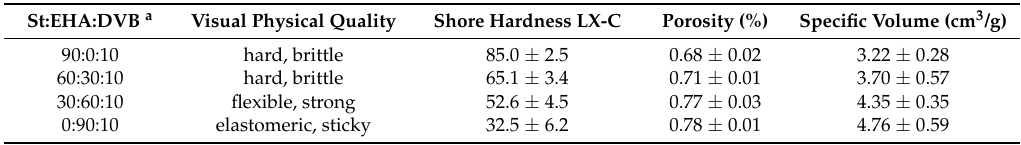
Table 1. HIPE compositions and quality of resulting PolyHIPE membrane.